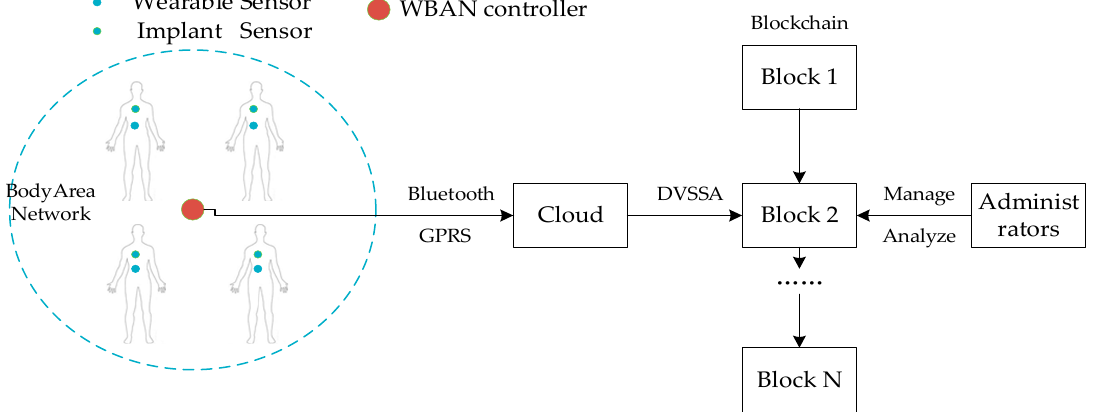
Figure 2. A wireless body area network (WBAN) architecture of a health care application.